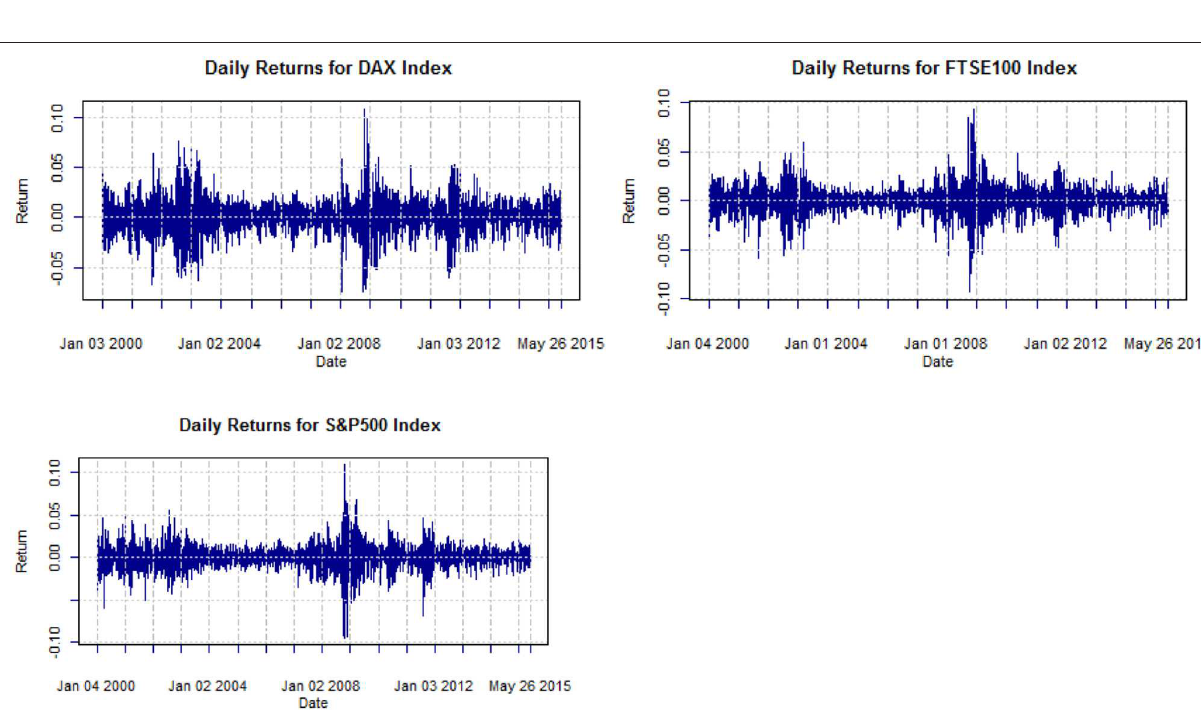
Frontiers in Applied Mathematics and Statistics | www.frontiersin.org